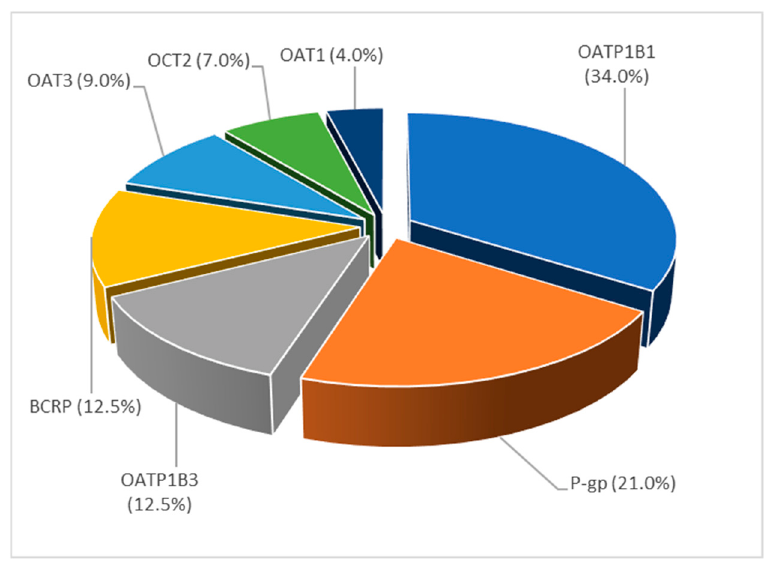
Figure 17. Distribution of published PBPK models in relation to the key analyzed transporter within topic 4, expressed as frequency (%), normalized to 100%.